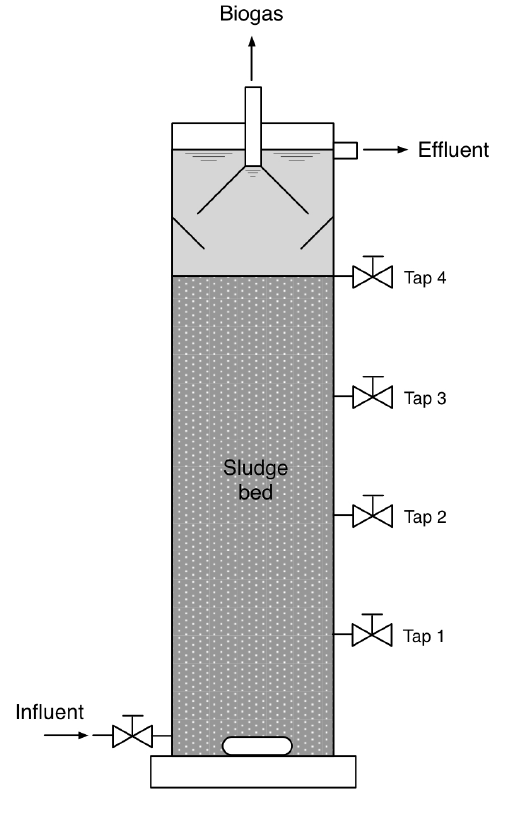
Figure 1. The up-flow anaerobic sludge blanket (UASB) reactor